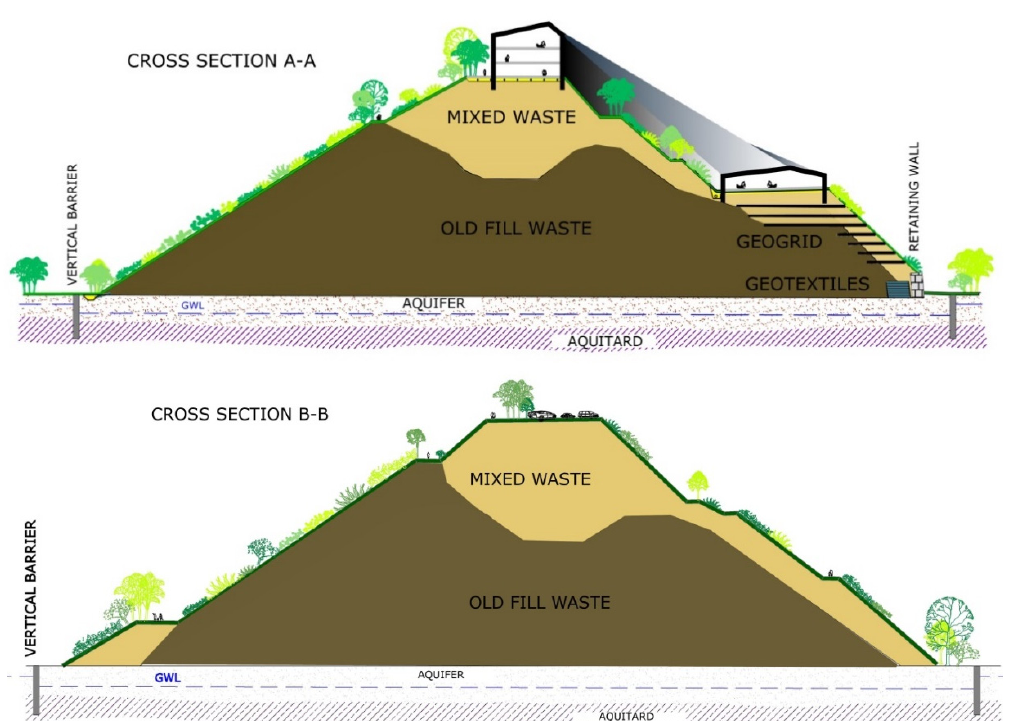
Figure 5. Cross-sections AA and BB (located in Figure 3), presenting the engineered slope geometry and reinforcement solutions.